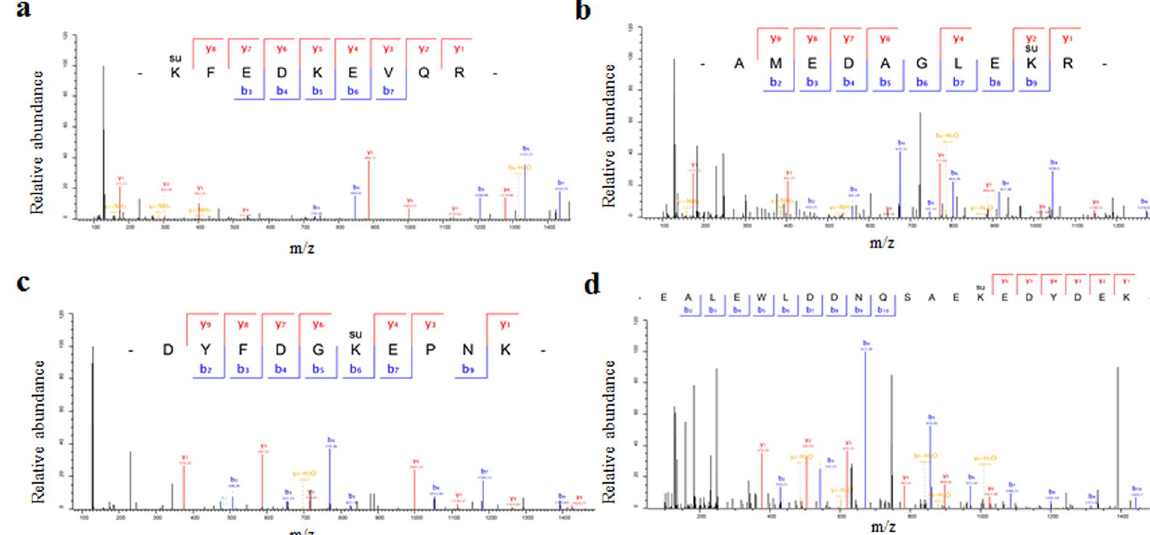
Figure 3. Four representative LC-MS/MS spectra of succinylated luminal-binding protein 5 (CL8488. Contig1_All). ( a ) Succinylated peptide K(su) FEDKEVQR, succinylation site at K109. ( b ) Succinylated peptide AMEDAGLEK(su)R, succinylation site at K360. ( c ) Succinylated peptide DYFDGK(su) EPNK, succinylation site at K389. ( d ) Succinylated peptide EALEWLDDNQSAEK(su) EDYDEK, succinylation site at K622.